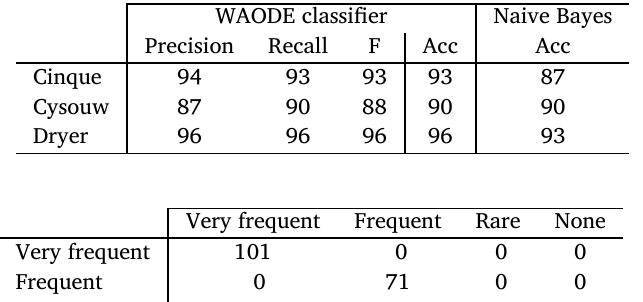
Confusion Matrix of WAODE classifier for Cinque’s model.